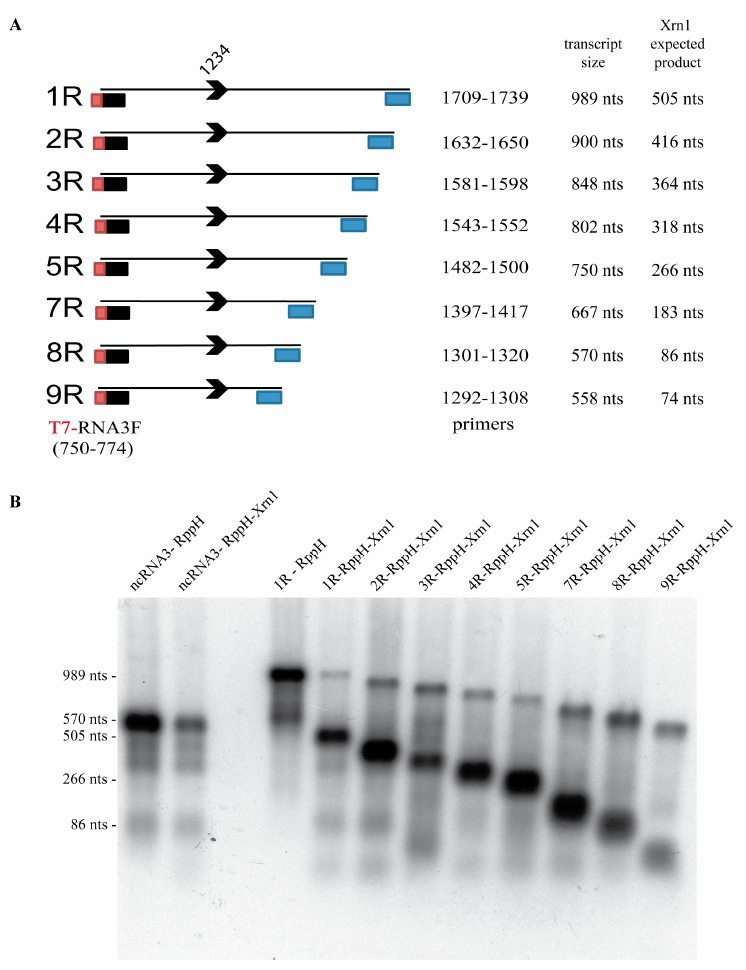
Figure 4. Characterization of the minimal RNA3 3 ′ domain required for the efficient stalling of the Xrn1 enzyme. ( A ) Representation of the fragments obtained using T7 promoter containing primer (T7-RNA3F) and reverse primers (positions specified by blue boxes) cloned into pUC57 that served as templates for the production of 1R to 9R transcripts, ranging from 989 to 558 nt, possessing the same 5 ′ extremity with decreasing 3 ′ end length. The arrowhead locates the 5 ′ position of the ncRNA3 species (nt 1234). The expected product size after RppH and Xrn1 treatments are specified. Construct 6R was not obtained; ( B ) after 6 h of RppH/Xrn1 treatment, RNAs were analyzed by a 24-cm long run on 1.5% denaturing-agarose gel followed by northern blot using a radiolabeled DNA oligomer probe complementary to the “coremin” sequence. The ncRNA3 transcripts and 1R transcripts were treated with RppH alone or with RppH and Xrn1. The lengths of some RNA species are specified on the left side.